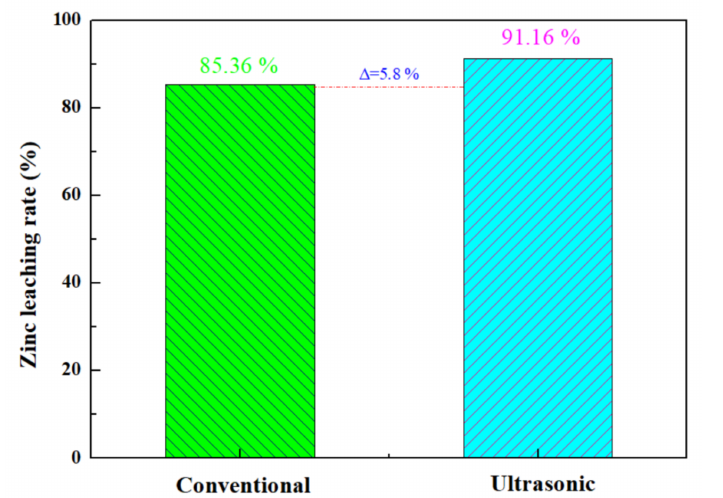
Figure 13. Comparison of zinc leaching rate between conventional and ultrasonic treatment of zinc oxide dust.